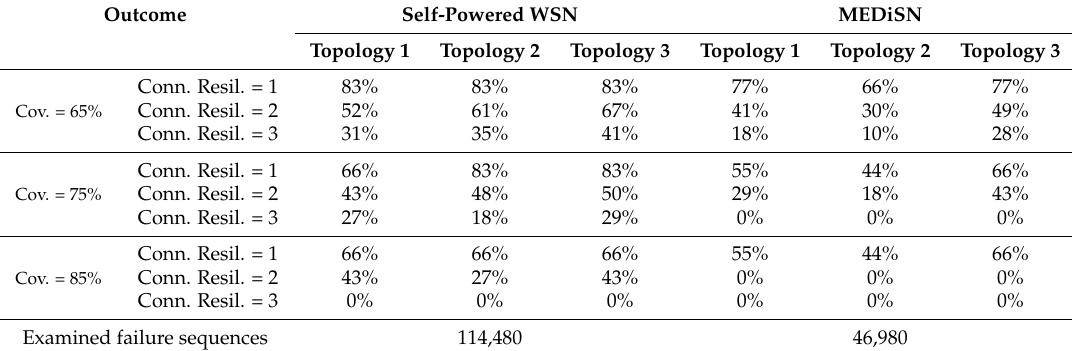
Table 3. Percentages of connection (Conn. Resil.) resiliency for the self-powered WSN and MEDiSN. Topology 1 is the original network, Topology 2 and 3 are attempts of coverage (see “Outcome”) improvement. Three thresholds of coverage (Cov. = 65%, 75% and 85%) have been selected. Self-Powered